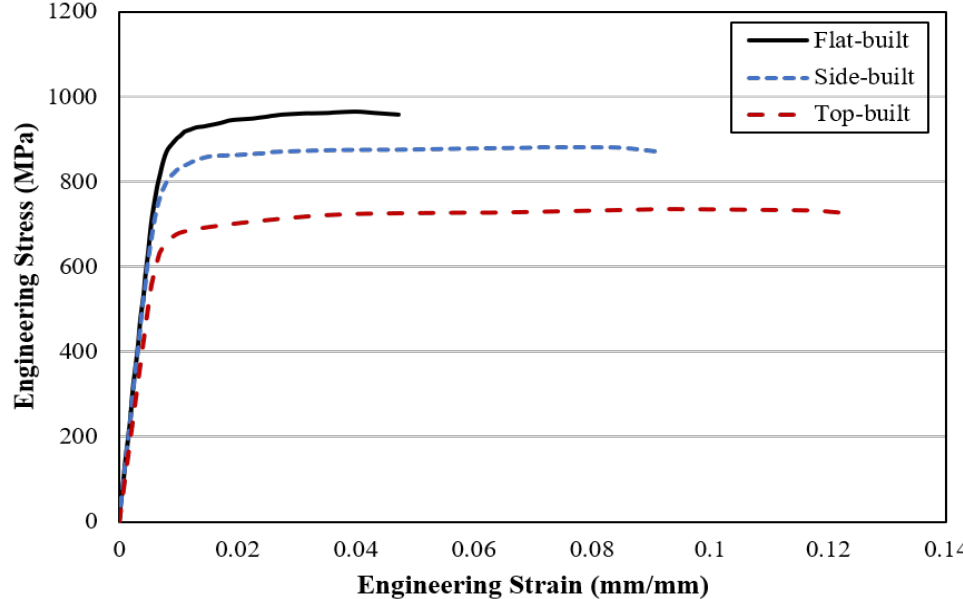
Figure 2. Engineering stress-strain curves of EBM Ti6Al4V parts from three different orientations (flat-built, side-built, and top-built) showing anisotropic flow stress properties .